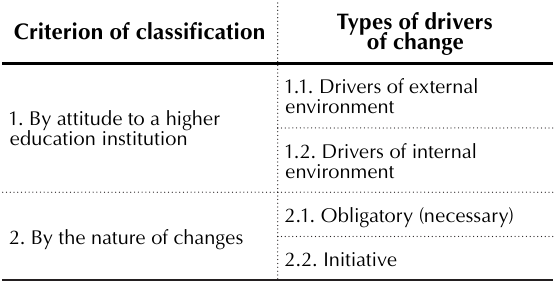
Table 1. Drivers of change in the higher